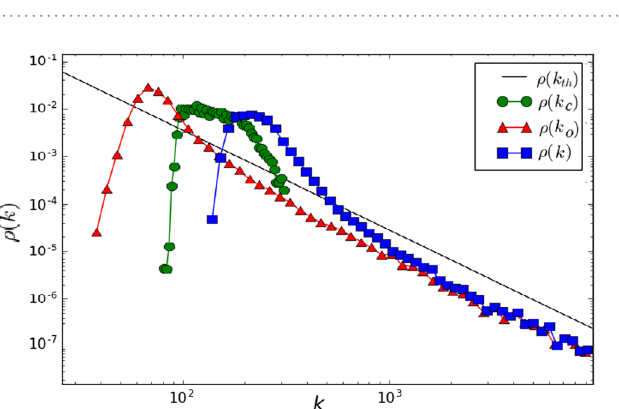
Figure 2. Time evolution of the average total degree, 〈 k ( a , s , t ) 〉 , for different activity classes and compared with the theoretical function of Eq. 3a,b,c and, evaluated considering a community size equal to the average (i.e. s = 〈 s 〉 ). The rescaled time is →  t at and 〈 〉  k at ( ) is plotted. Parameters used are: N = 10 5 , ω = 2.1, ν = 2.1,